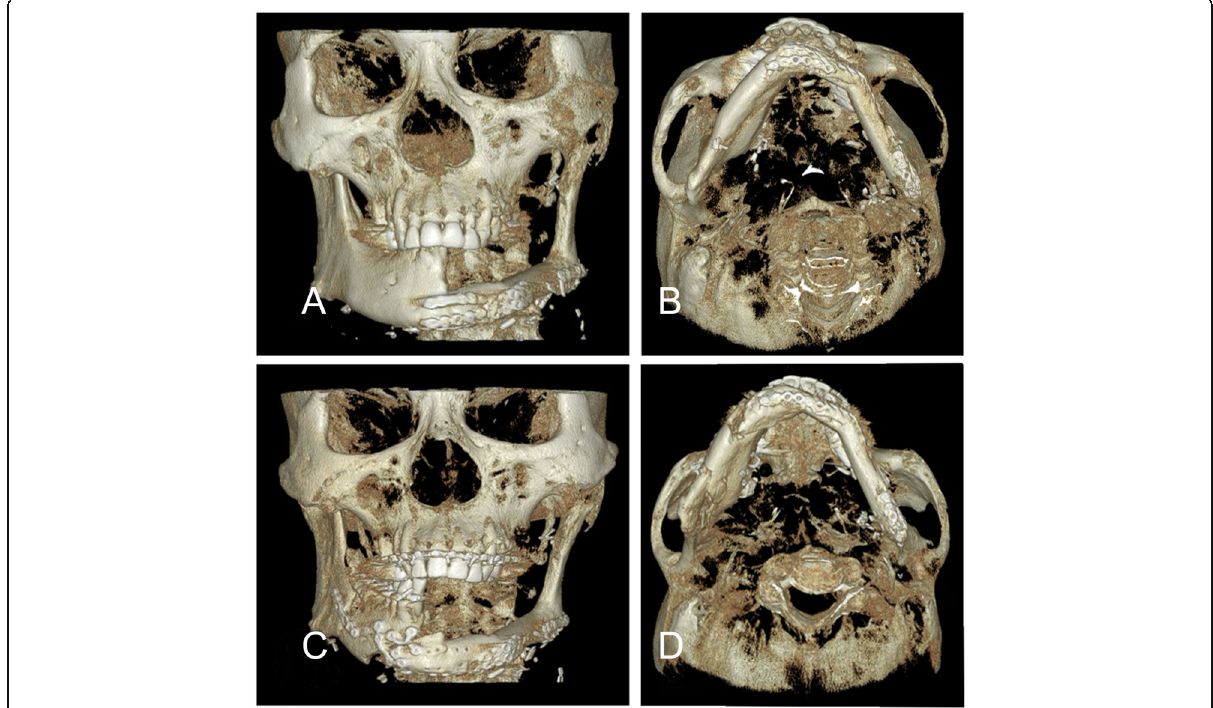
Fig. 4 Restoration of occlusion and facial contour by sliding osteotomy combined with SSRO. a , b The patient ’ s mandible was moved posterolaterally to the previously operated left side, c , d but occlusion and facial contour were restored after surgery with sufficient bone contact at the junctions of the